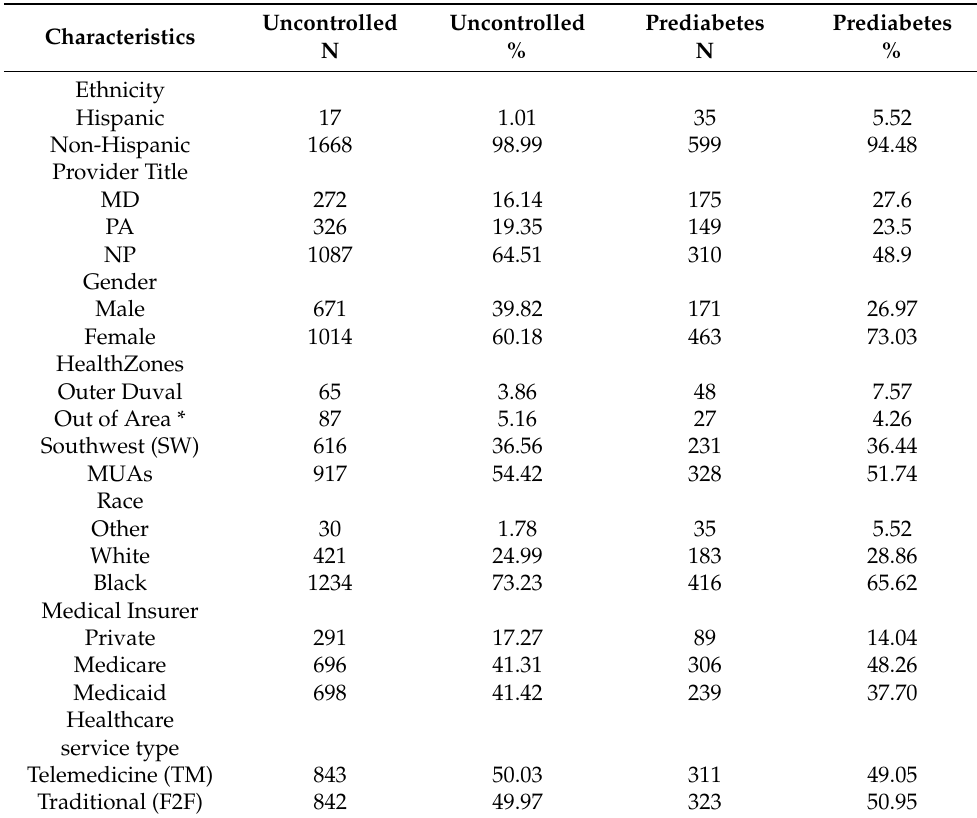
Table 1. Descriptive Statistics for T2DM patient visits with uncontrolled diabetes and prediabetes.